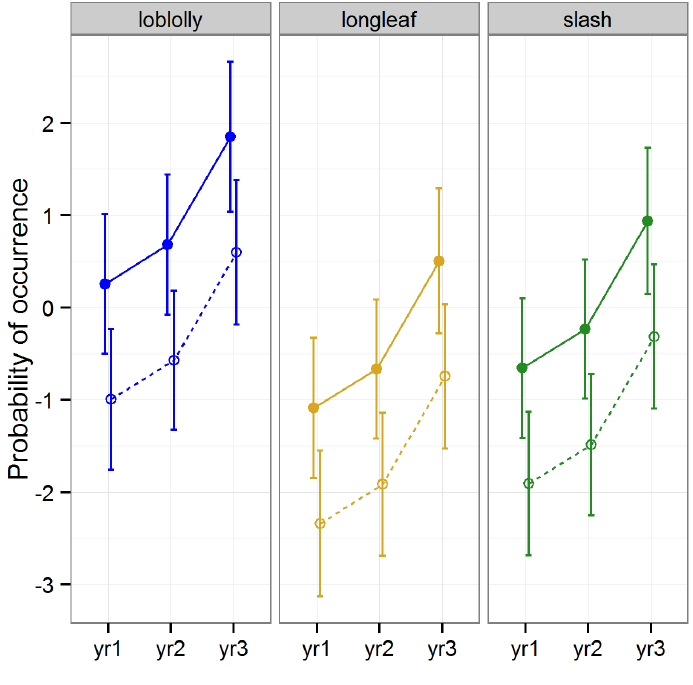
Figure 8. Predicted means and standard errors of Blattodea occurrence during three years of seasonal pitfall trapping in pine plantations in North Florida against fixed effects from the most parsimonious model based on log-likelihood ratio tests; raked stands are displayed with open circles and dashed lines, intact stands with solid circles and lines; 2008 as yr1, 2009 as yr2 and 2010 as